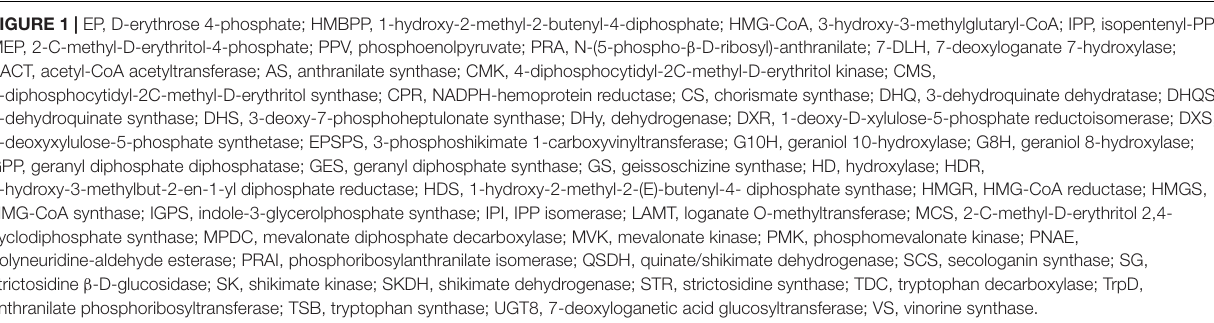
FIGURE 1 | EP, D-erythrose 4-phosphate; HMBPP, 1-hydroxy-2-methyl-2-butenyl-4-diphosphate; HMG-CoA, 3-hydroxy-3-methylglutaryl-CoA; IPP, isopentenyl-PP; MEP, 2-C-methyl-D-erythritol-4-phosphate; PPV, phosphoenolpyruvate; PRA, N-(5-phospho- β -D-ribosyl)-anthranilate; 7-DLH, 7-deoxyloganate 7-hydroxylase; AACT, acetyl-CoA acetyltransferase; AS, anthranilate synthase; CMK, 4-diphosphocytidyl-2C-methyl-D-erythritol kinase; CMS, 4-diphosphocytidyl-2C-methyl-D-erythritol synthase; CPR, NADPH-hemoprotein reductase; CS, chorismate synthase; DHQ, 3-dehydroquinate dehydratase; DHQS, 3-dehydroquinate synthase; DHS, 3-deoxy-7-phosphoheptulonate synthase; DHy, dehydrogenase; DXR, 1-deoxy-D-xylulose-5-phosphate reductoisomerase; DXS, 1-deoxyxylulose-5-phosphate synthetase; EPSPS, 3-phosphoshikimate 1-carboxyvinyltransferase; G10H, geraniol 10-hydroxylase; G8H, geraniol 8-hydroxylase; GPP, geranyl diphosphate diphosphatase; GES, geranyl diphosphate synthase; GS, geissoschizine synthase; HD, hydroxylase; HDR, 4-hydroxy-3-methylbut-2-en-1-yl diphosphate reductase; HDS, 1-hydroxy-2-methyl-2-(E)-butenyl-4- diphosphate synthase; HMGR, HMG-CoA reductase; HMGS, HMG-CoA synthase; IGPS, indole-3-glycerolphosphate synthase; IPI, IPP isomerase; LAMT, loganate O-methyltransferase; MCS, 2-C-methyl-D-erythritol 2,4- cyclodiphosphate synthase; MPDC, mevalonate diphosphate decarboxylase; MVK, mevalonate kinase; PMK, phosphomevalonate kinase; PNAE, polyneuridine-aldehyde esterase; PRAI, phosphoribosylanthranilate isomerase; QSDH, quinate/shikimate dehydrogenase; SCS, secologanin synthase; SG, strictosidine β -D-glucosidase; SK, shikimate kinase; SKDH, shikimate dehydrogenase; STR, strictosidine synthase; TDC, tryptophan decarboxylase; TrpD, anthranilate phosphoribosyltransferase; TSB, tryptophan synthase; UGT8, 7-deoxyloganetic acid glucosyltransferase; VS, vinorine